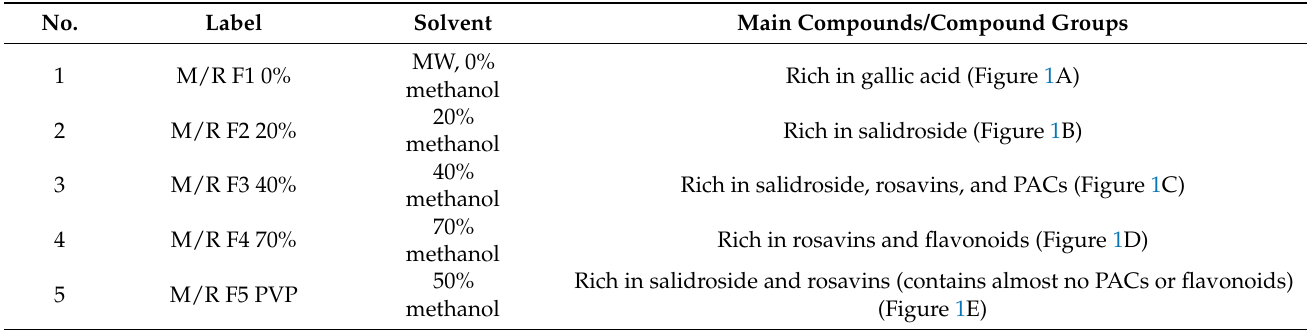
Fractions obtained from “Mattmark” and “Rosavine” ethanolic extracts and their main